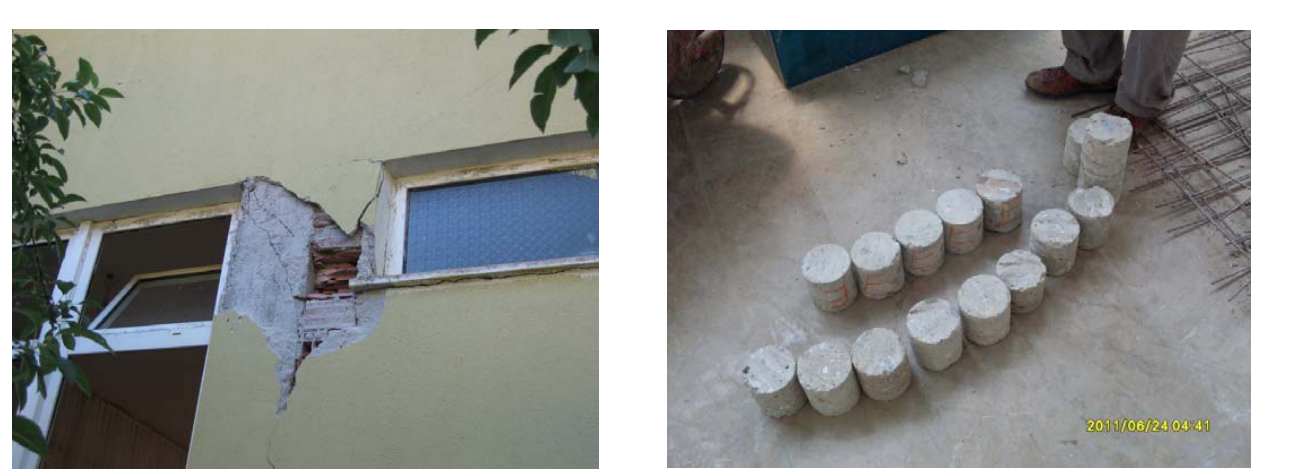
Fig. 13. Obtained core